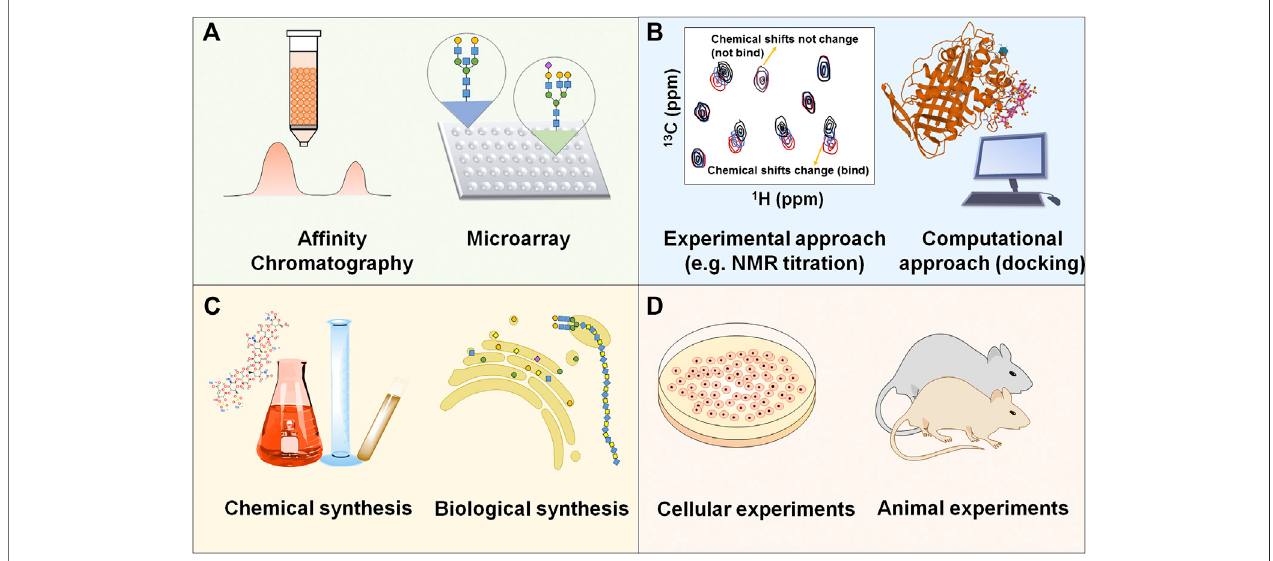
FIGURE 3 | Schematic strategy of developing novel therapeutics based on the speci fi c interaction between GAGs and proteins (A) Discovering GAG-protein binding. (B) Elucidating the molecular mechanism between the binding. (C) Synthesizing speci fi c GAG oligosaccharides or analogs. (D) Evaluating the ef fi cacy and toxicity in vitro and in vivo